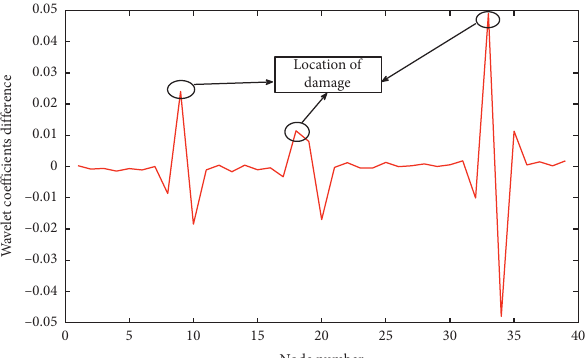
Figure 13: Wavelet coefficient differences of 5%, 6%, and 10% for damage in sections 9, 19, and 34, respectively.